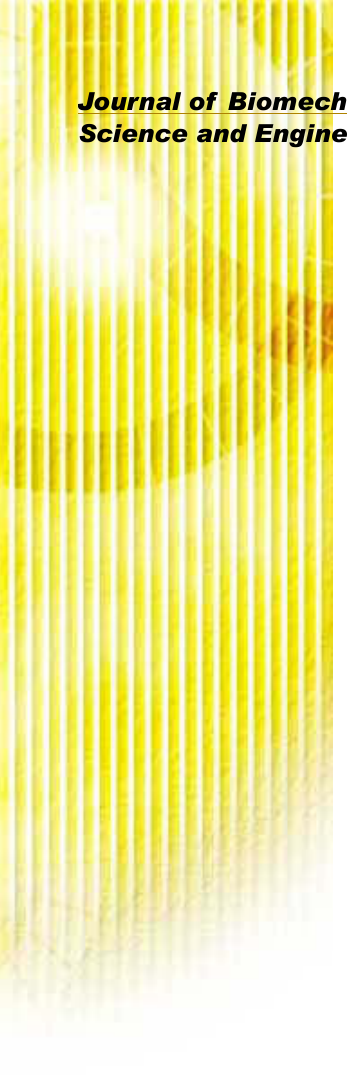
The change of stress is described as a percent change according to the acetabular cup and liner thickness (Fig. 6). For all three sizes of ball head, the maximum stress decreased as the liner and acetabular cup thickness increased. When changing the acetabular cup thickness, the maximum stress occurred in the case of the 28 mm ball head and 3 mm acetabular cup. Meanwhile, when changing the liner thickness, the maximum stress occurred in the case of the 28 mm ball head and 9 mm liner. Thus, the most unstable model was the 28 mm ball head with a 3 mm acetabular cup and 9 mm liner. In contrast, the maximum stress was almost 37% lower for the most stable case: the 36 mm ball head with a 5 mm acetabular cup and 11 mm liner.